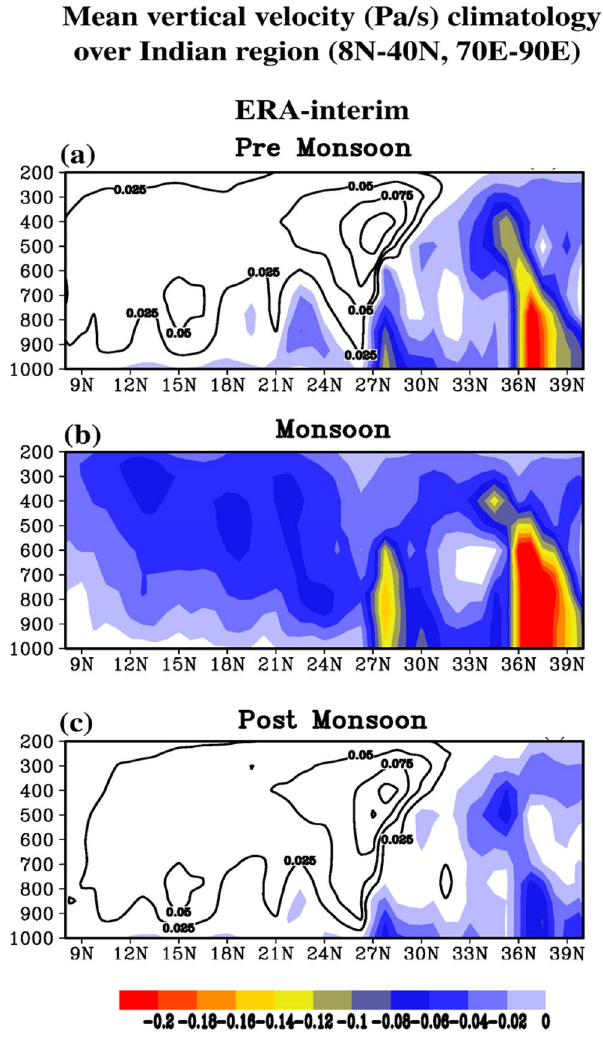
Figure 8. Mean vertical velocity climatology over the Indian region (8N-40N, 70E-90E) from ERA-interim data for the period 1979–2006. Units are Pascals (Pa) per second (s); negative values (upward motion) are shaded while positive values (downward motion) are unshaded. ( a )Pre-monsoon, ( b )monsoon, and ( c )post-monsoon periods are for April 1 – March 31, July 1 – September 30, and January 1 – March 31, respectively, as defined throughout the